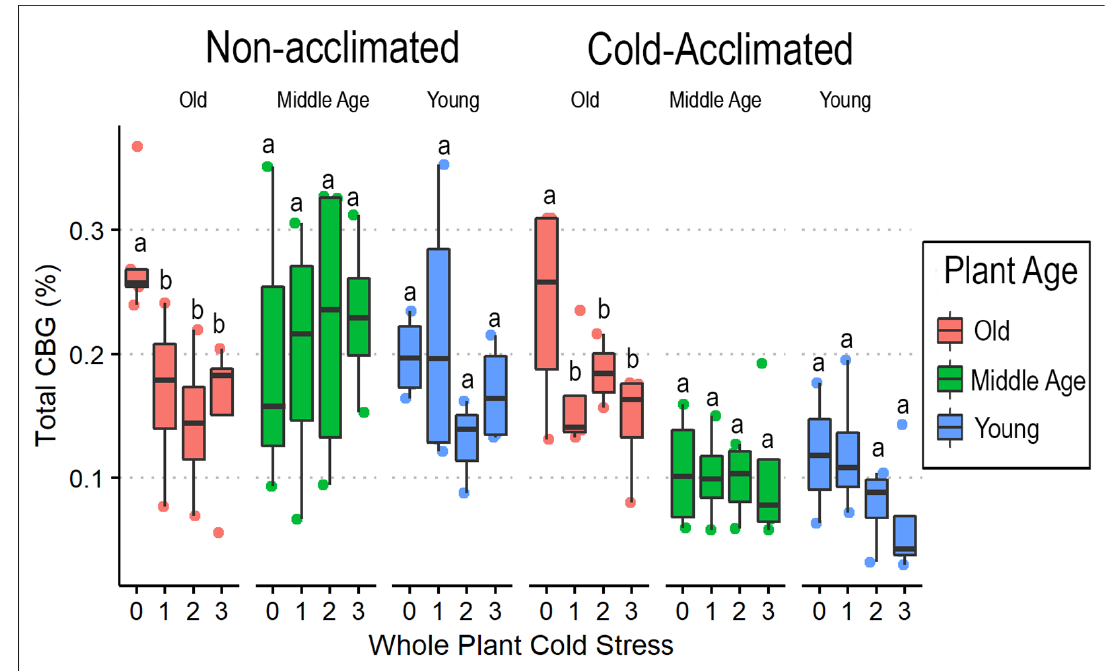
Figure 7. Total CBG (%) box plots comparing whole-plant cold stress to acclimation treatment and plant age in ‘AutoCBD’. Data represent the percentage of CBG added to the product of the percentage of CBGA multiplied by the cannabinoid’s molecular weight ratio (0.878 and 0.877). Plants receiving cold acclimation treatment were subject to 10 days at 10 °C. Whole-plant cold stress consisted of a control treatment receiving no cold exposure, 0 (control); a single 3 h − 0.5 °C exposure, 1 ; two consecutive 3 h − 0.5 °C exposures separated by 24 h, 2 ; and three 3 h − 0.5 °C exposures separated by 24 h, 3 . Plant age treatments include oldest plants, middle-age plants, and youngest plants (68, 54, and 40 days old on the day of whole-plant cold stress, respectively). Letters indicate differences amongst consecutive cold exposures between cultivars, plant age, and acclimation. Lowercase letters indicate significant differences ( p < 0.05) between treatments (Tukey’s test).